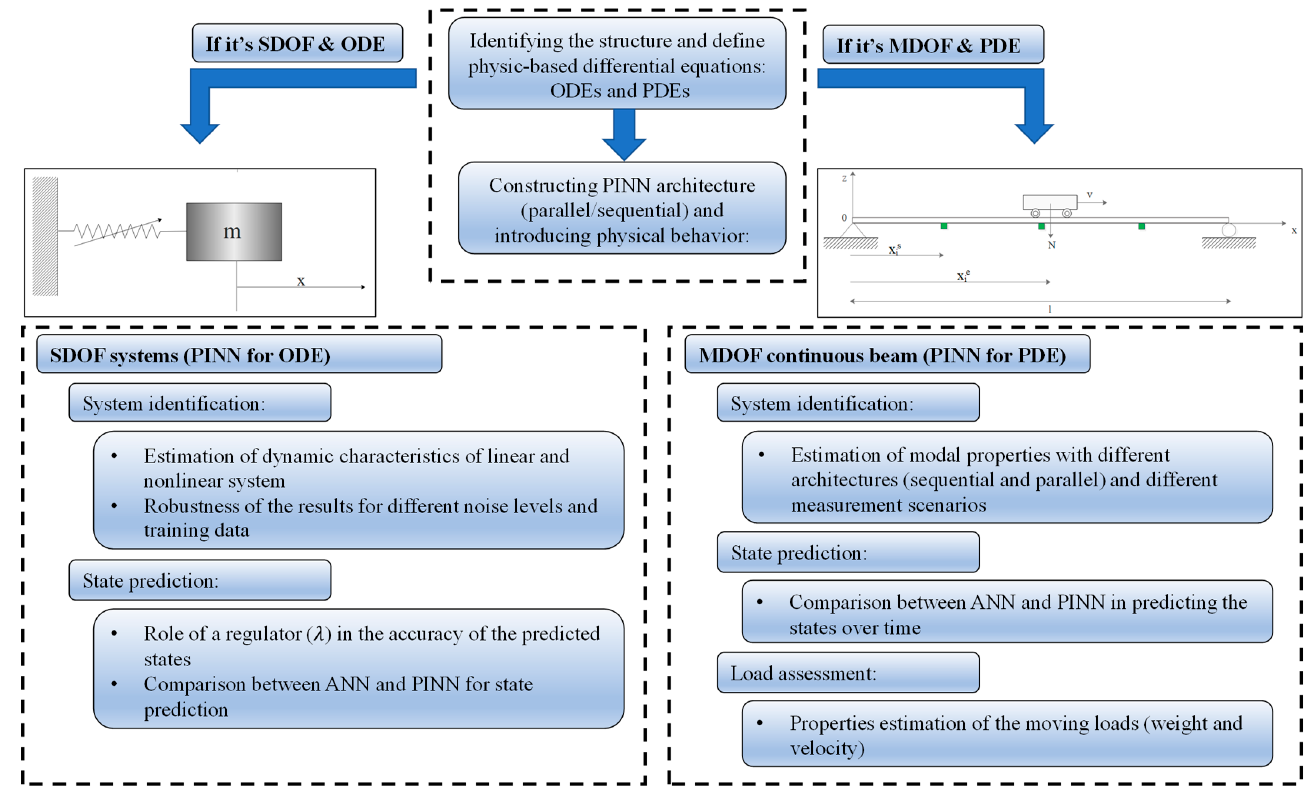
Figure 5. The workflow of the paper and demonstrative examples .